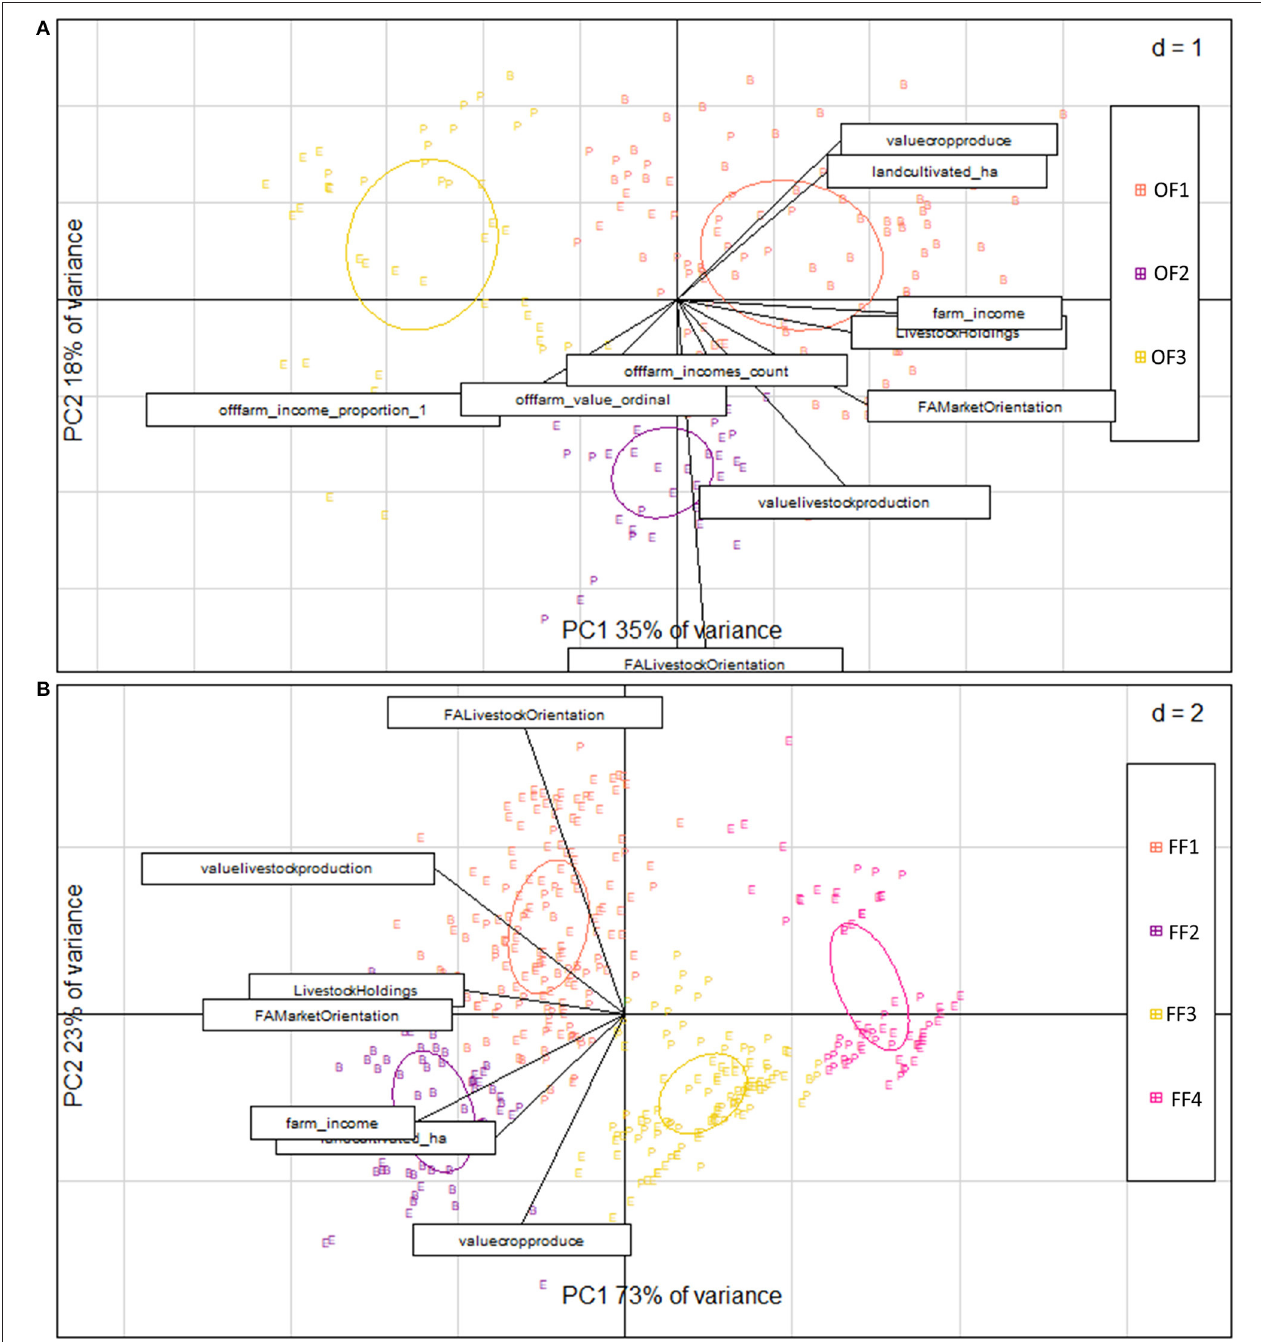
FIGURE 3 | Between class principal component analysis assessing correlations between farm production and household livelihood strategy types. (A) Livelihood strategies that incorporated off-farm income. (B) Farm-focused livelihood strategies. Letters correspond to country location of household (B = Bolivia, E = Ecuador, P = Peru). Ellipses correspond to livelihood strategy defined by hierarchical clustering ( Table 2